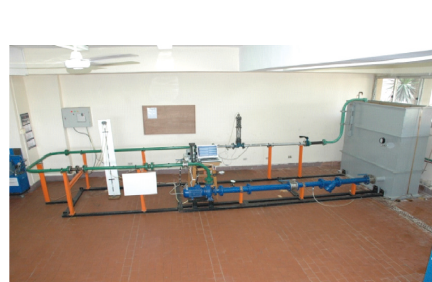
Figure 6: Experimental test rig.